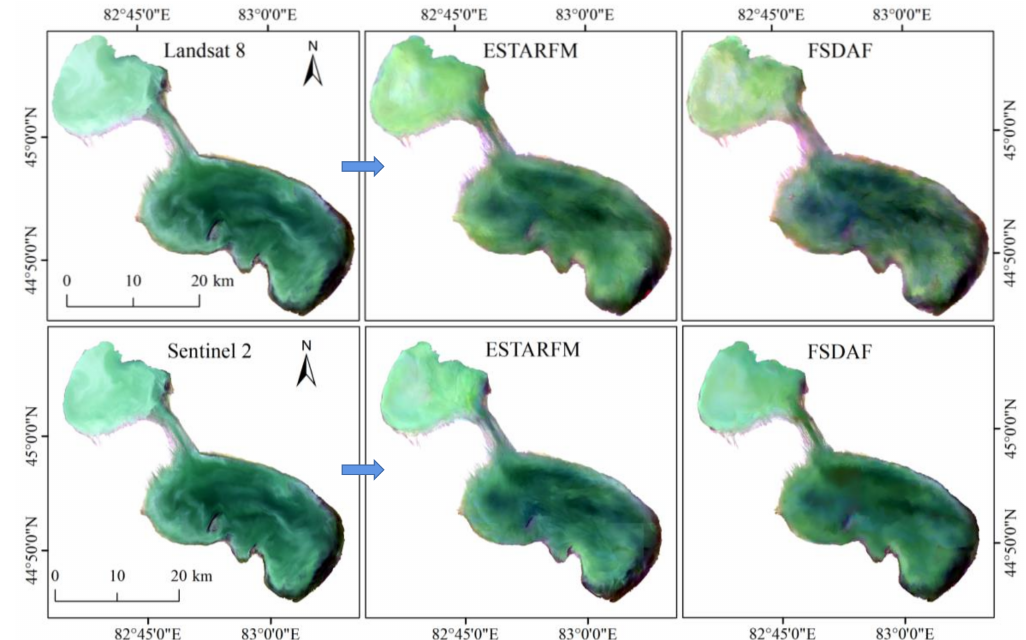
Figure 6. Spatiotemporal fusion images of Ebinur Lake (to the left of the blue arrow are the original images of Landsat 8 and Sentinel 2 on 29 August 2017. On the right of the arrow are the fusion images on 29 August 2017 obtained by different spatiotemporal fusion